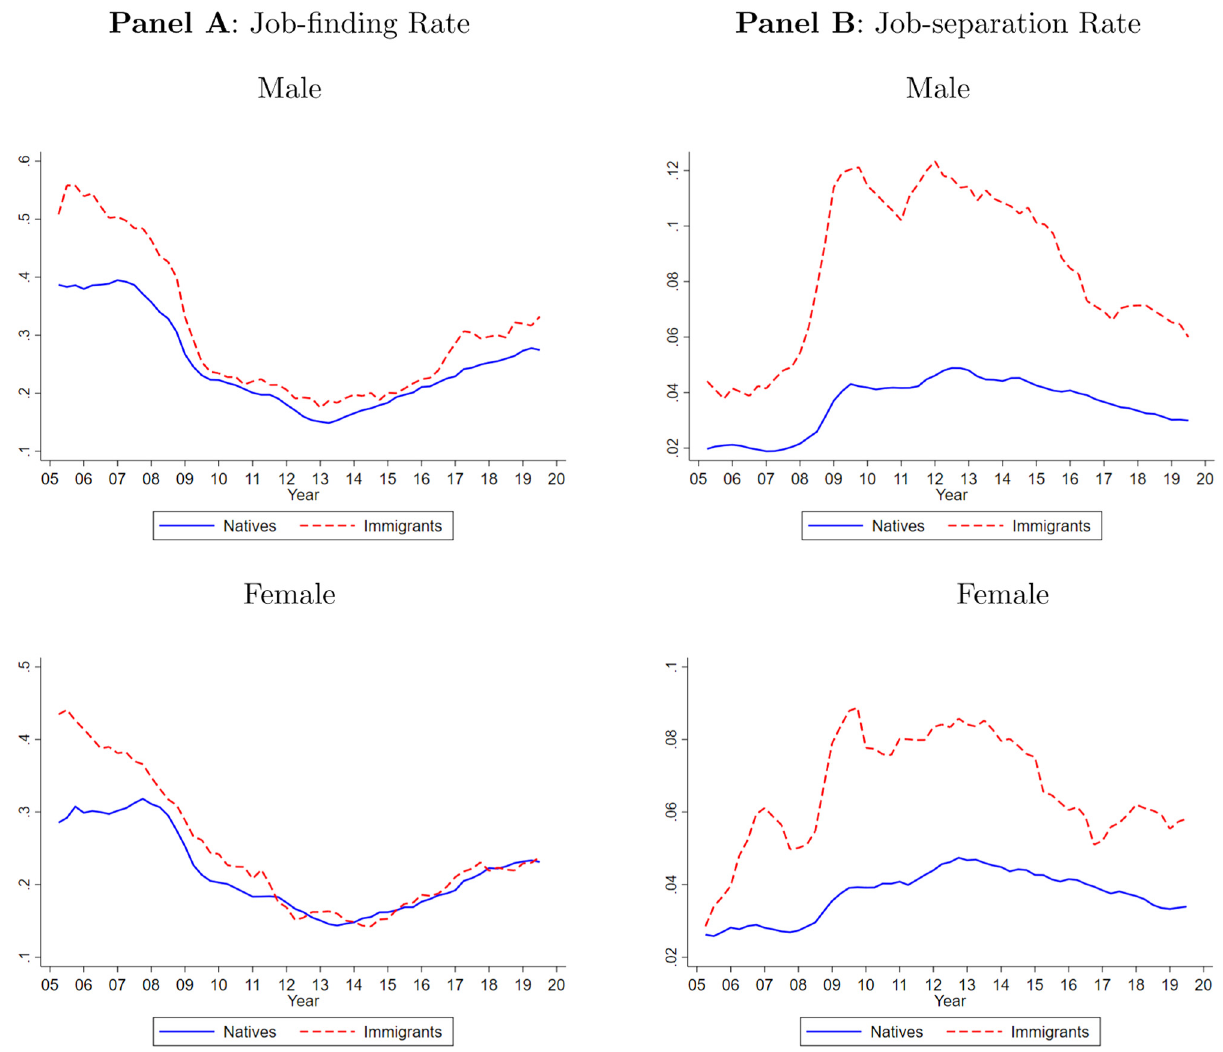
Figure A8: Labour market transitions by nationality and gender. ( a ) Job - fi nding rate. ( b ) Job - separation rate. Note: The transitions are seasonally adjusted using a 4 - quarters moving average, constructed from the Spanish Labour Force Survey -